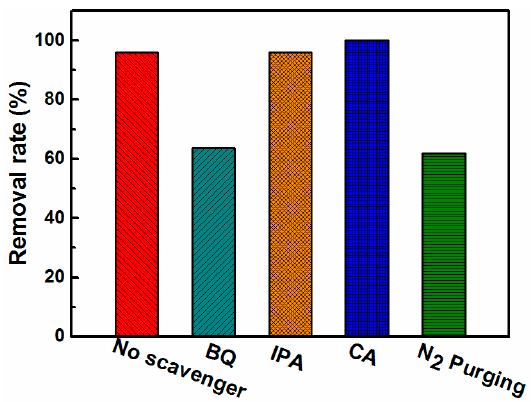
Figure 9. The e ff ect of di ff erent reactive species scavengers on the Cr(VI) photo-degradation over Figure 9. The effect of different reactive species scavengers on the Cr(VI) photo-degradation over 5%- 5%-ZnO / Bi 2 S 3 ZnO/Bi 2 S 3 composite.